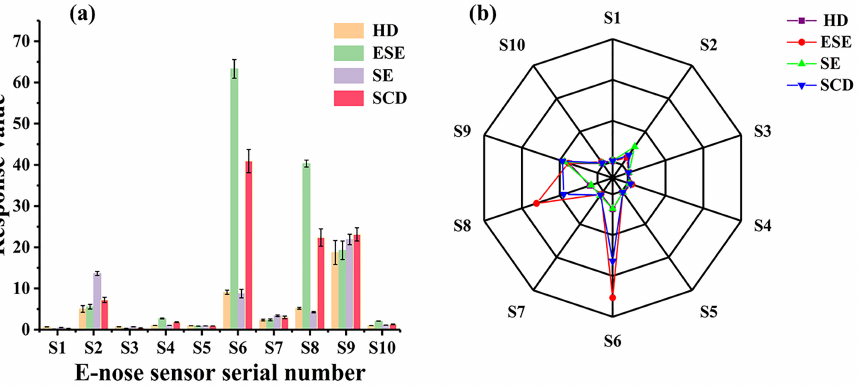
Figure 1. ( a ) Column chart and ( b ) radar map of the E-nose of SAEOs extracted by different meth- ods.